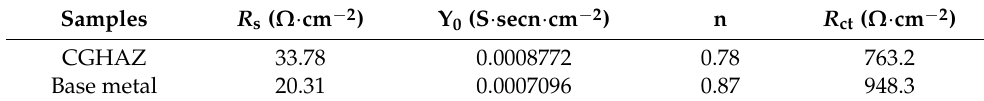
Figure 6. The impedance diagrams for the base metal and CGHAZ in 3.5 wt.% NaCl. ( a ) Nyquist plots, ( b , c ) Bode plots and ( d ) proposed equivalent circuit. Table 5. Electrochemical parameters de1duced by EIS method in 3.5 wt.% NaCl solution.